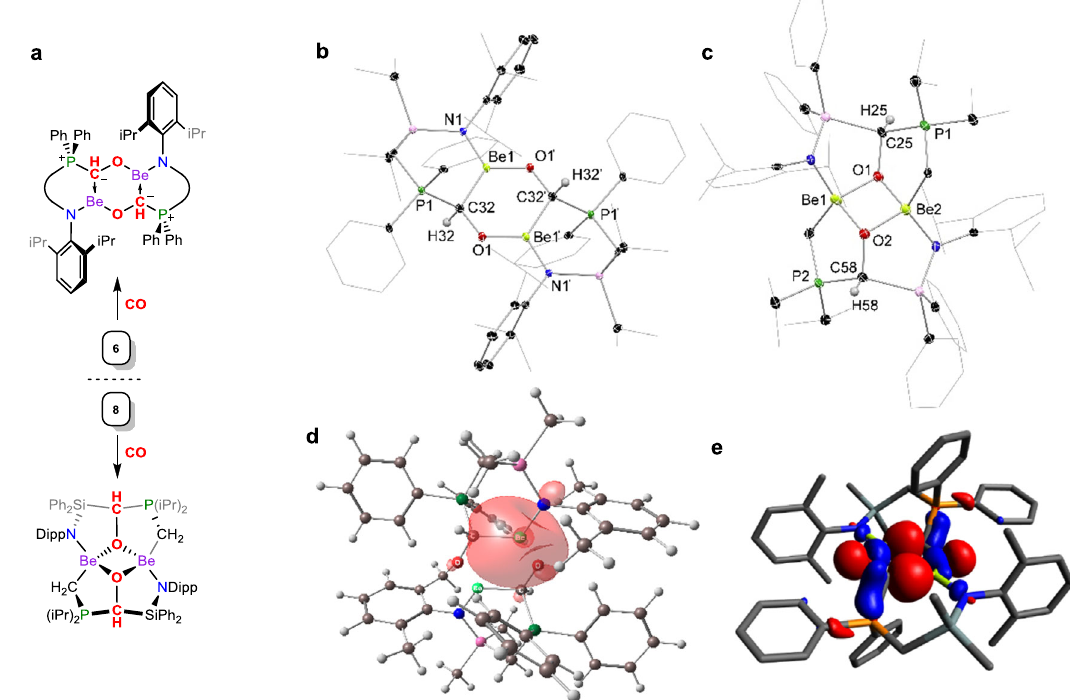
Fig. 4 Synthesis and X-ray crystal structures of compounds 11 and 12, the DFT-derived HOMO of 11moiety is ( – 4.04 eV), and the NBO-derived depiction of the dative C → Be interaction in 11moiety is. The reaction of CO with hydride complex 6 leads insertion into each Be – H bond, leading to 11 . The divergent reaction of CO with hydride complex 8 also proceeds through insertion into the Be – H fragments, but follows through ligand-activation. a Synthesis of compounds 6 and 8 . b Solid state structure of complex 11 . c Solid state structure of complex 12 . Thermal ellipsoids for 11 and 12 at 30% probability. Selected distances (Å) and angles (°) for 11 : Be1 – O1 ′ 1.503(5); Be1 – C32 1.807(5); Be1 – N1 1.606(4); P1 – C32 1.772(3); O1 – C32